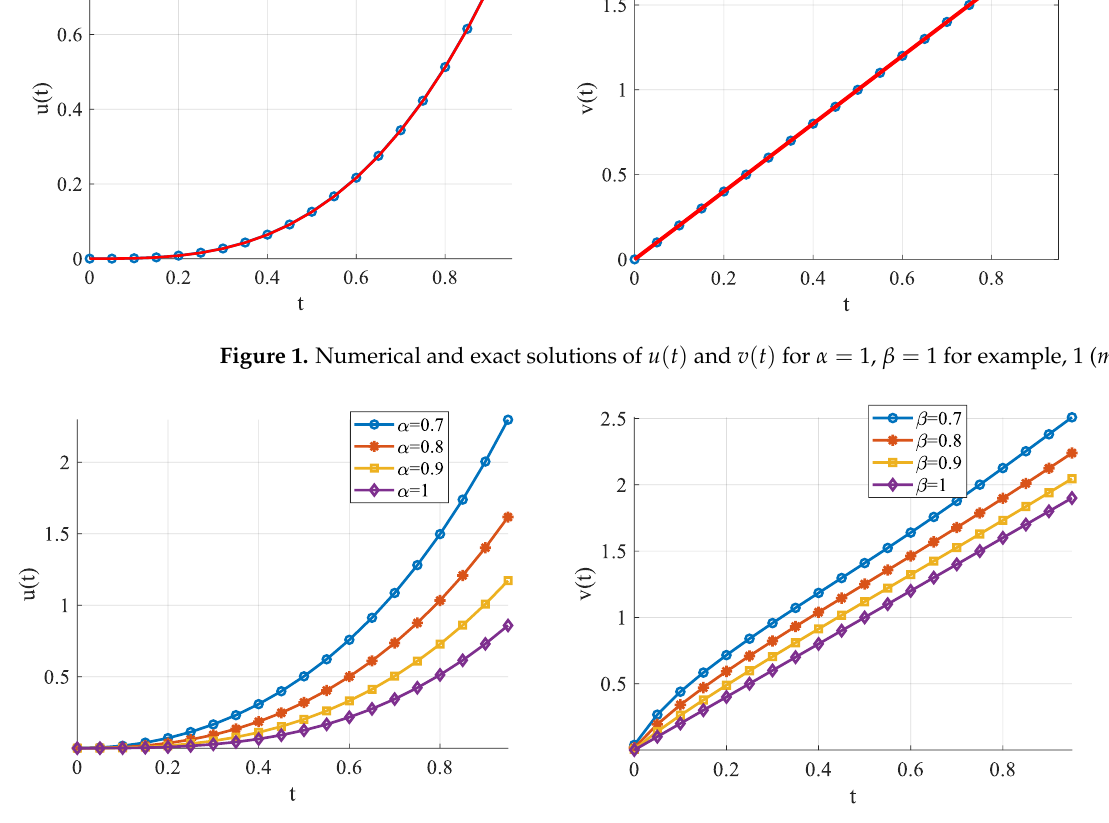
Figure 2. Numerical solutions of and for several fractional orders for example 1 ( ) u t